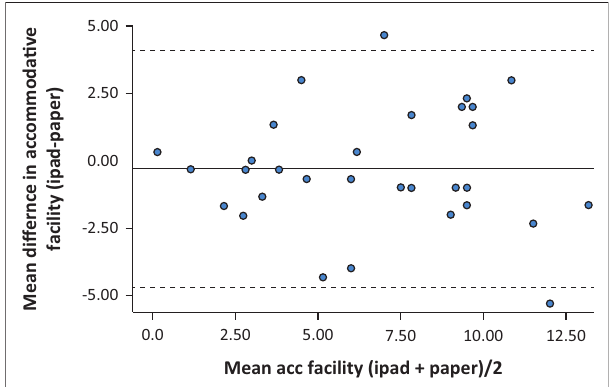
FIGURE 2: Bland Altman plot for mean differences between the measured accommodative facility to targets on the iPad and the paper-based